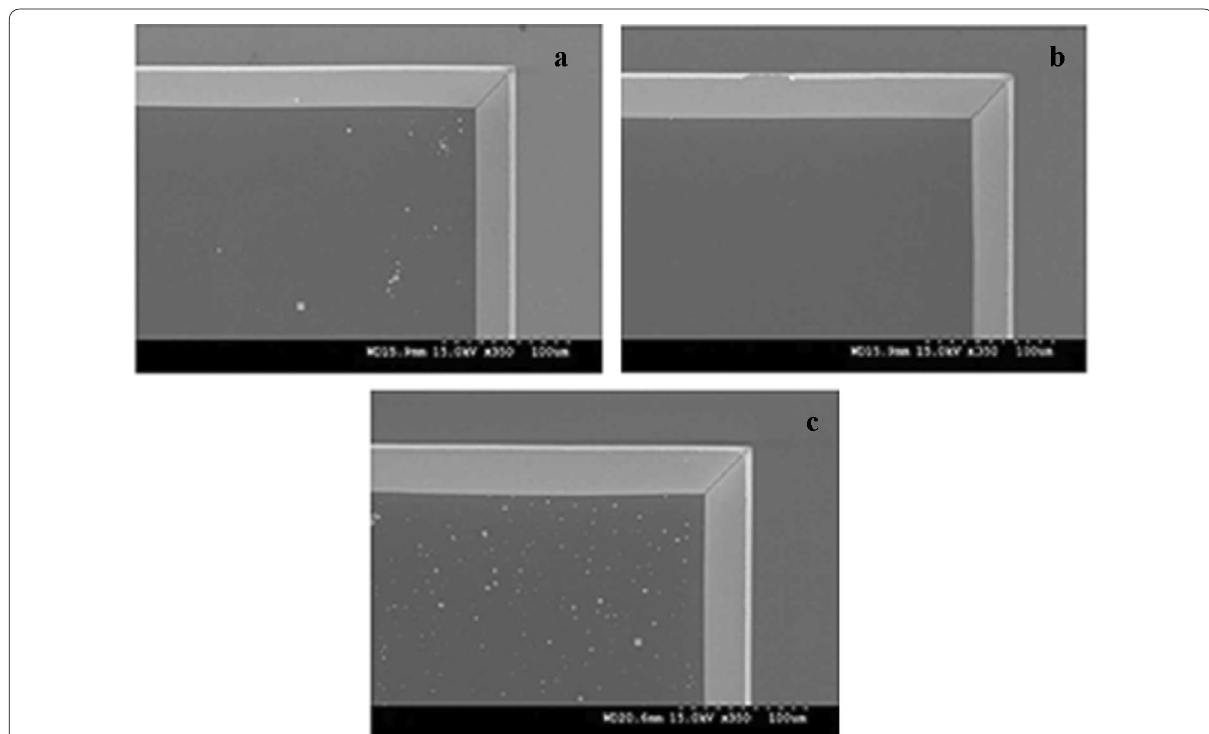
Fig. 38 SEM images of the etched Si{100} surface with various concentrations of ammonium persulfate (AP): a 1.0 g AP, b 2.5 g AP, c 5.0 g AP in per